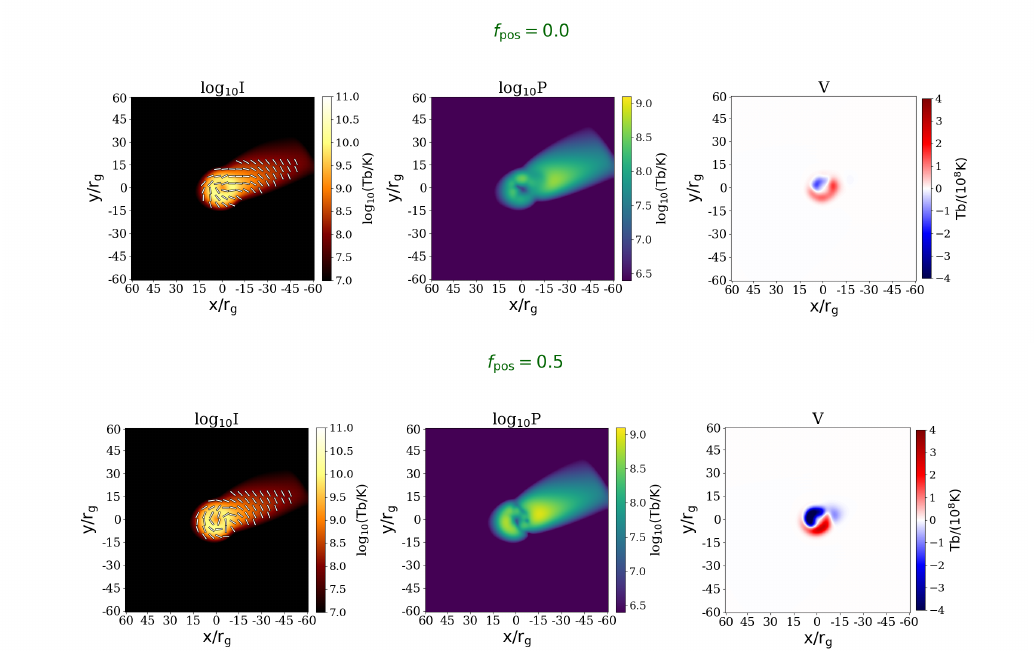
Figure 2. Down rows present the polarized map of M87* inferred from the constant β model at 230 GHz. We have fixed β e = 0.01, and the power-law index at p = 3.5. From the ( top ) to ( bottom ), we present the images for f pos = 0.0,0.5, respectively.